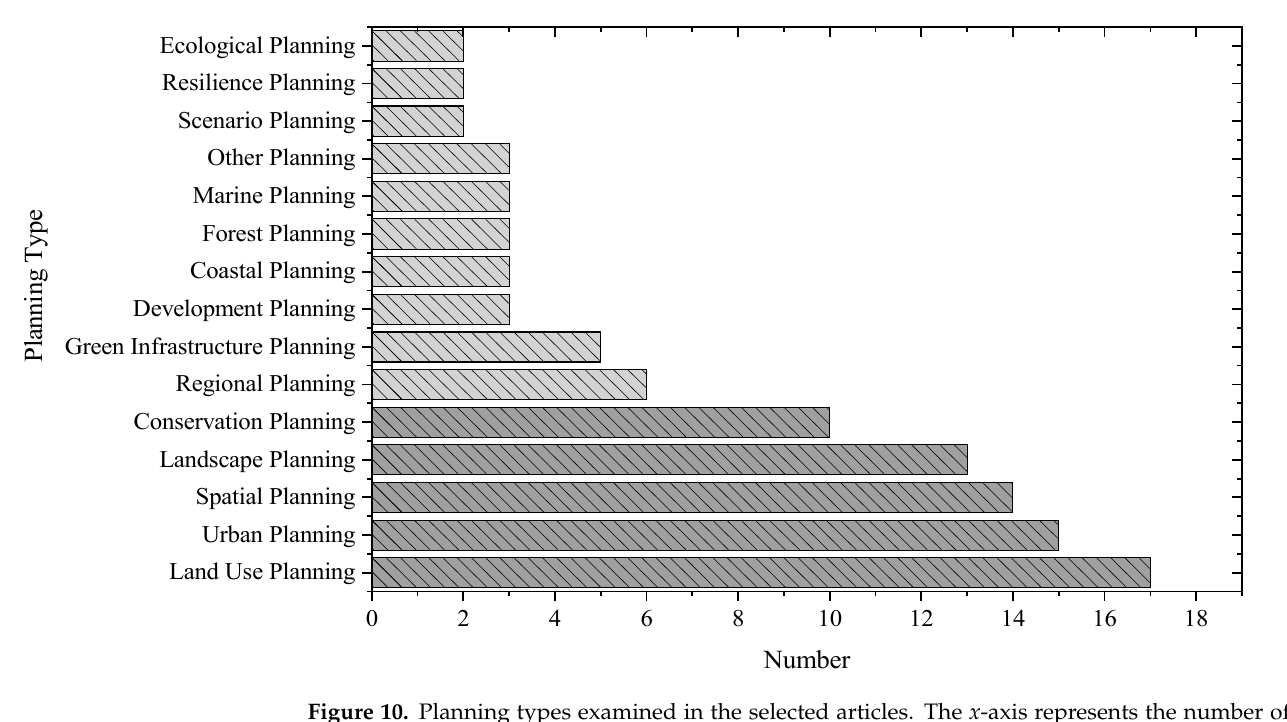
Figure 11. Data types used in the selected articles. The x -axis represents the number of different data types.